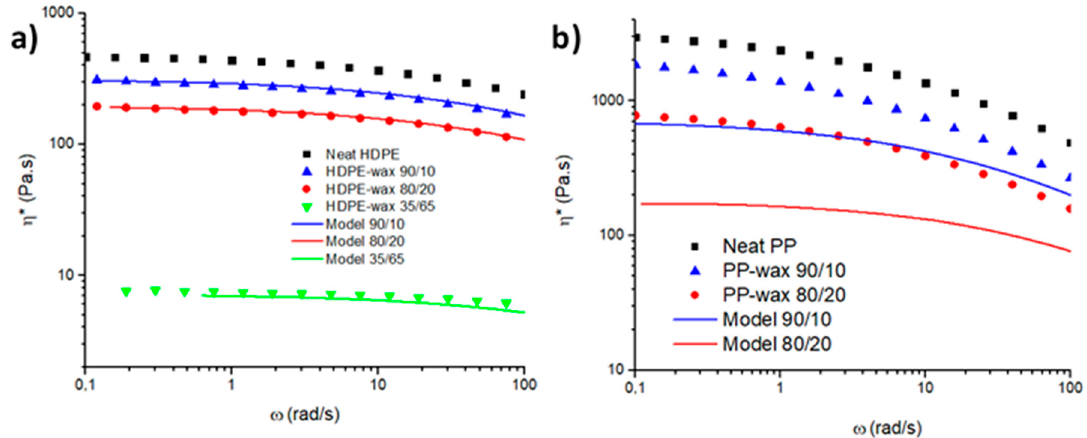
Figure5. Absolutecomplexviscosityofpolymer / waxesblendswithvaryingwaxcontent: ( a )HDPE / wax Figure 5. Absolute complex viscosity of polymer/waxes blends with varying wax content: ( a ) and ( b ) PP / wax. The model is from the work of Robert et al. HDPE/wax and ( b ) PP/wax. The model is from the work of Robert et al. [36].